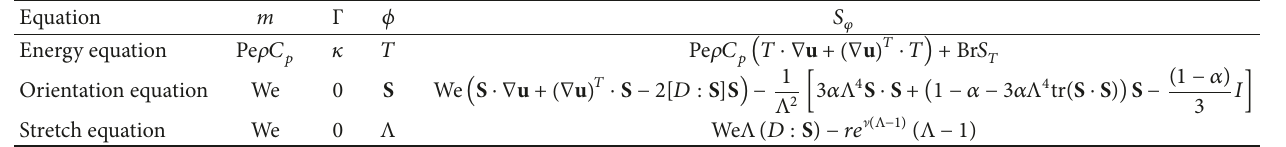
Table 1: Definition of constants, physical quantities, and source term in